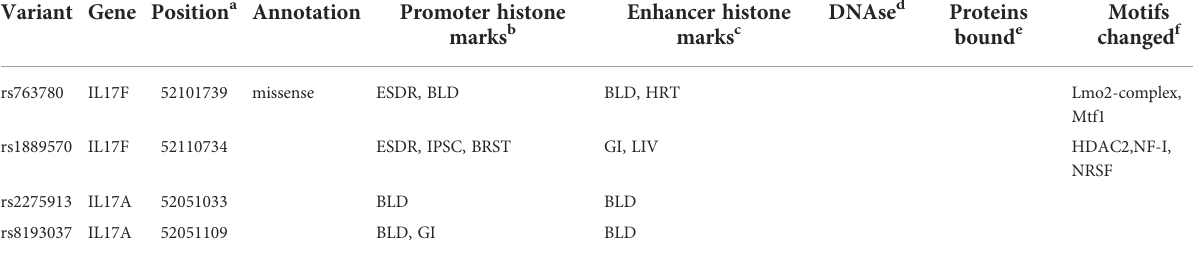
TABLE 3 Summary of functional annotations for 4 SNPs in 6 human diseases (strong epidemiological credibility). Variant Gene Position a